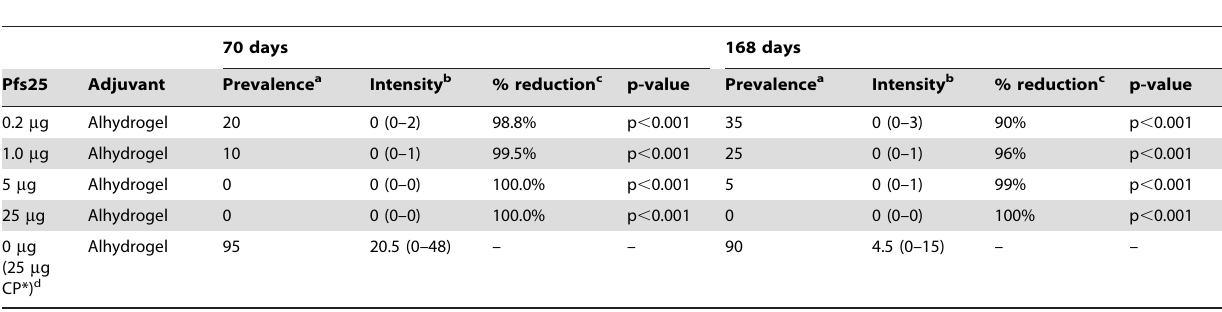
Table 3. Evaluation of TB activity in immunized mouse sera by SMFA: one vaccine